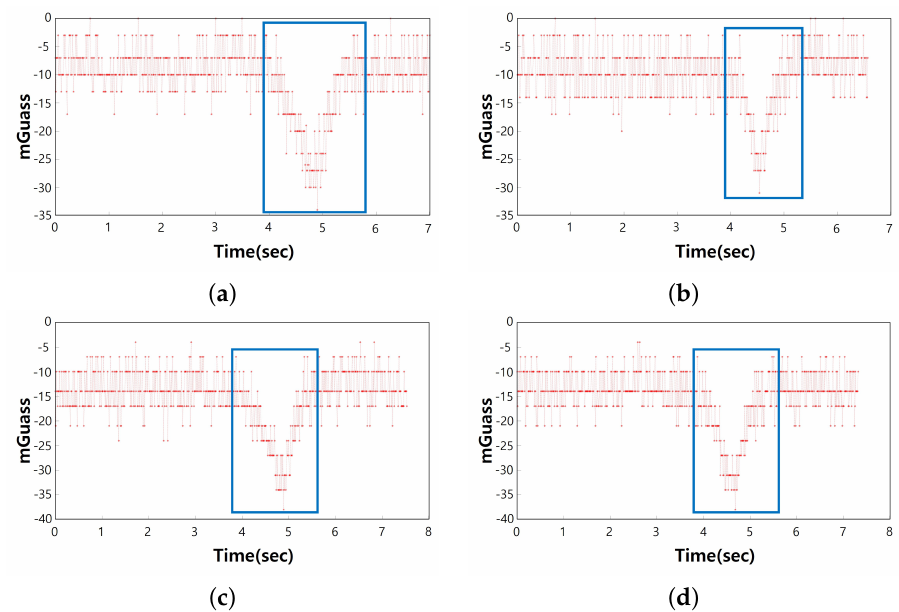
Figure 10. Raw dataset 30 cm × 30 cm × 30 cm samples. ( a ) is z-axis 1ch of sample 1 data and ( b ) is z-axis 1ch of sample 2 data, ( c ) is z-axis 1ch of sample 3 data, ( d ) is z-axis 1ch of sample 4